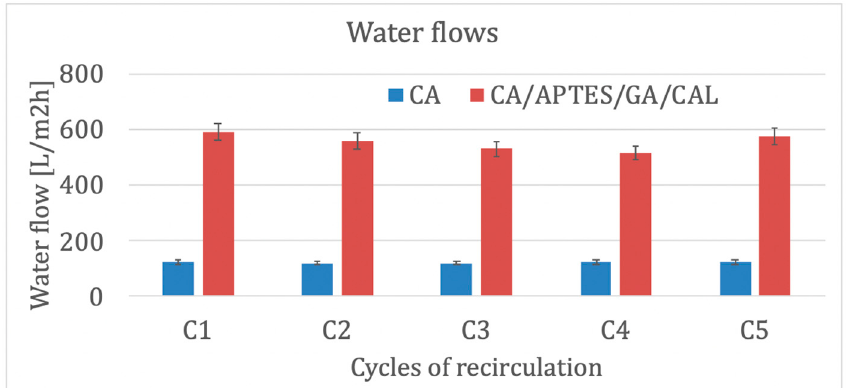
Figure 10. Water flows through CA and CA/APTES/GA/CAL membranes. Five different measurements for calculating standard error.